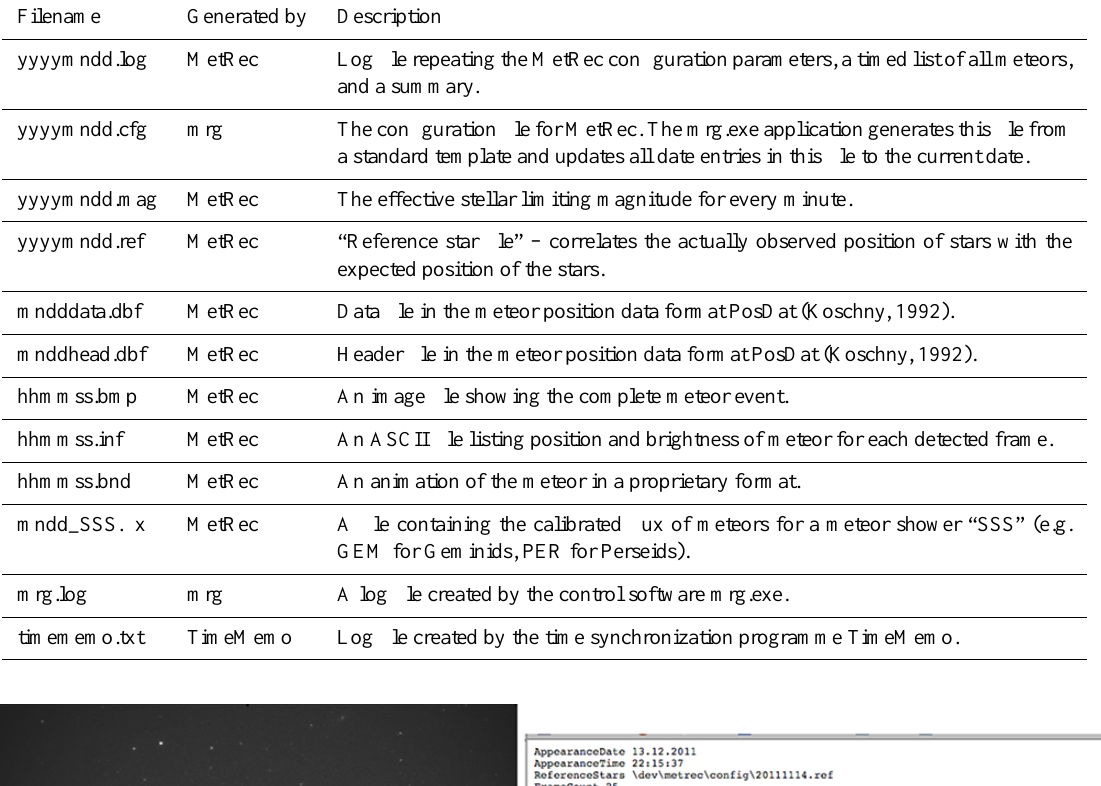
Table 3. The data which the system generates automatically every night.